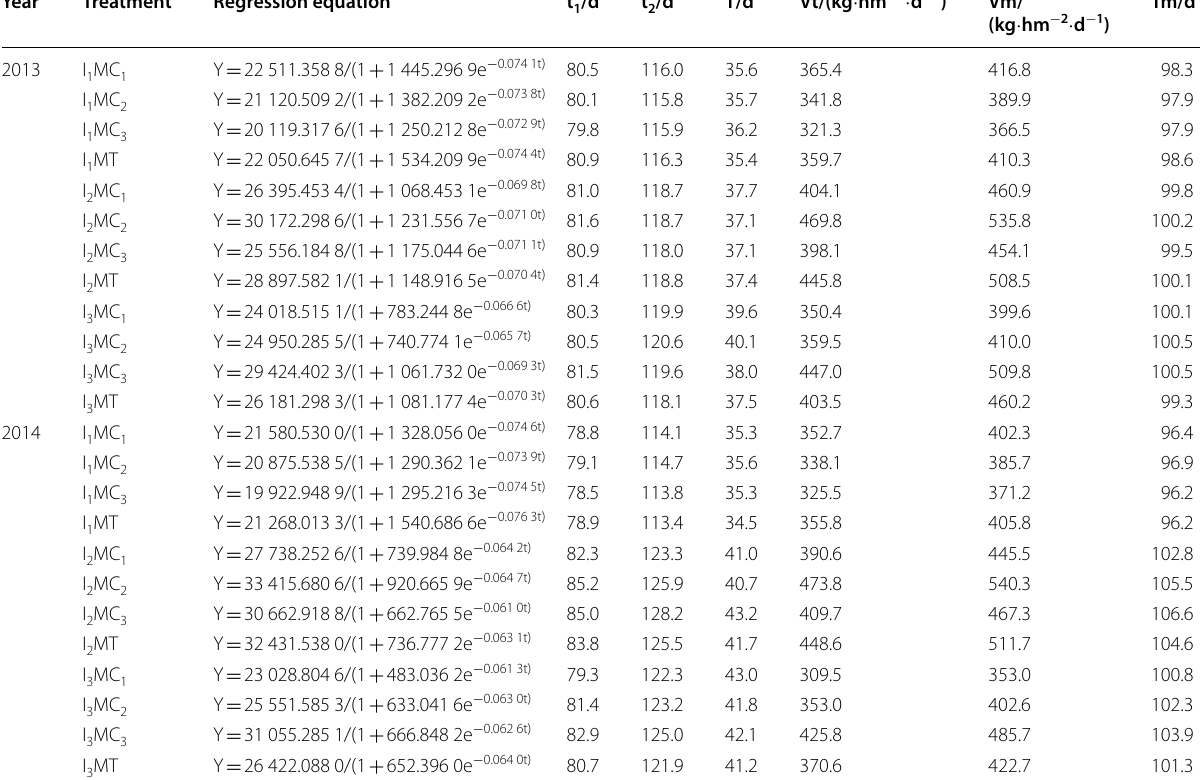
Table 4 Simulation equation and eigenvalue of cotton reproductive organs biomass accumulation Year